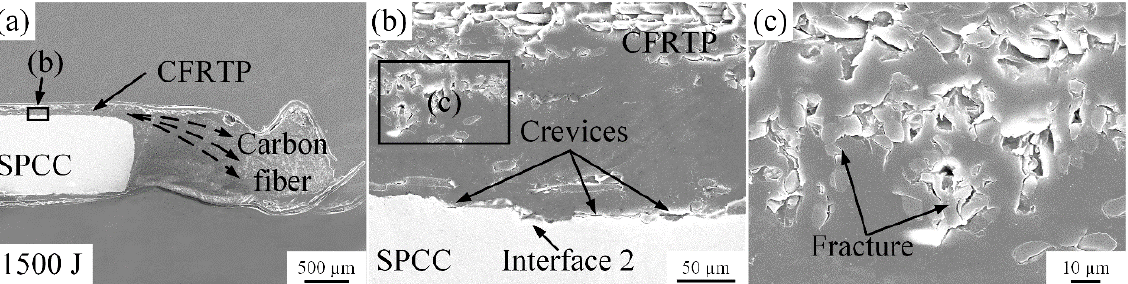
Figure 12. Microstructure of the joint cross-section at the 1500 J energy: ( a ) carbon fibers squeezed out phenomenon; ( b ) situation of interface 1 and 2; ( c ) fractures on carbon fiber.